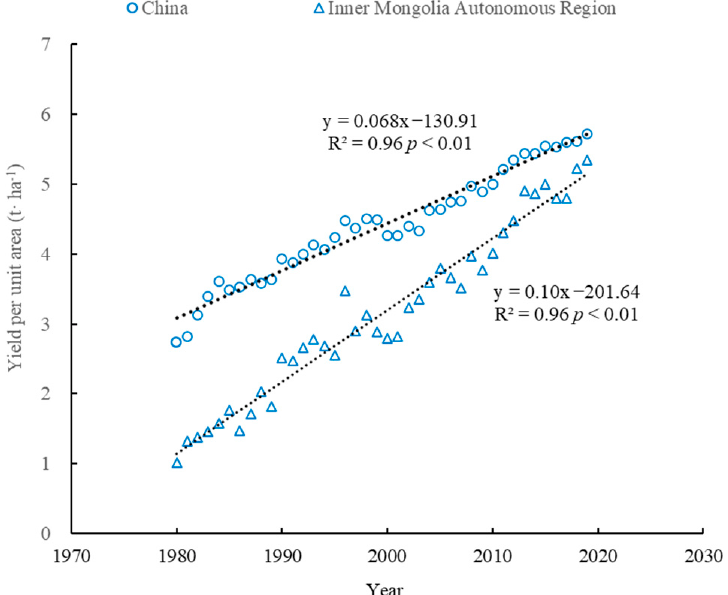
Figure 6. Yield in Inner Mongolia Autonomous Region from 1980 to 2019, and a comparison with the national average.